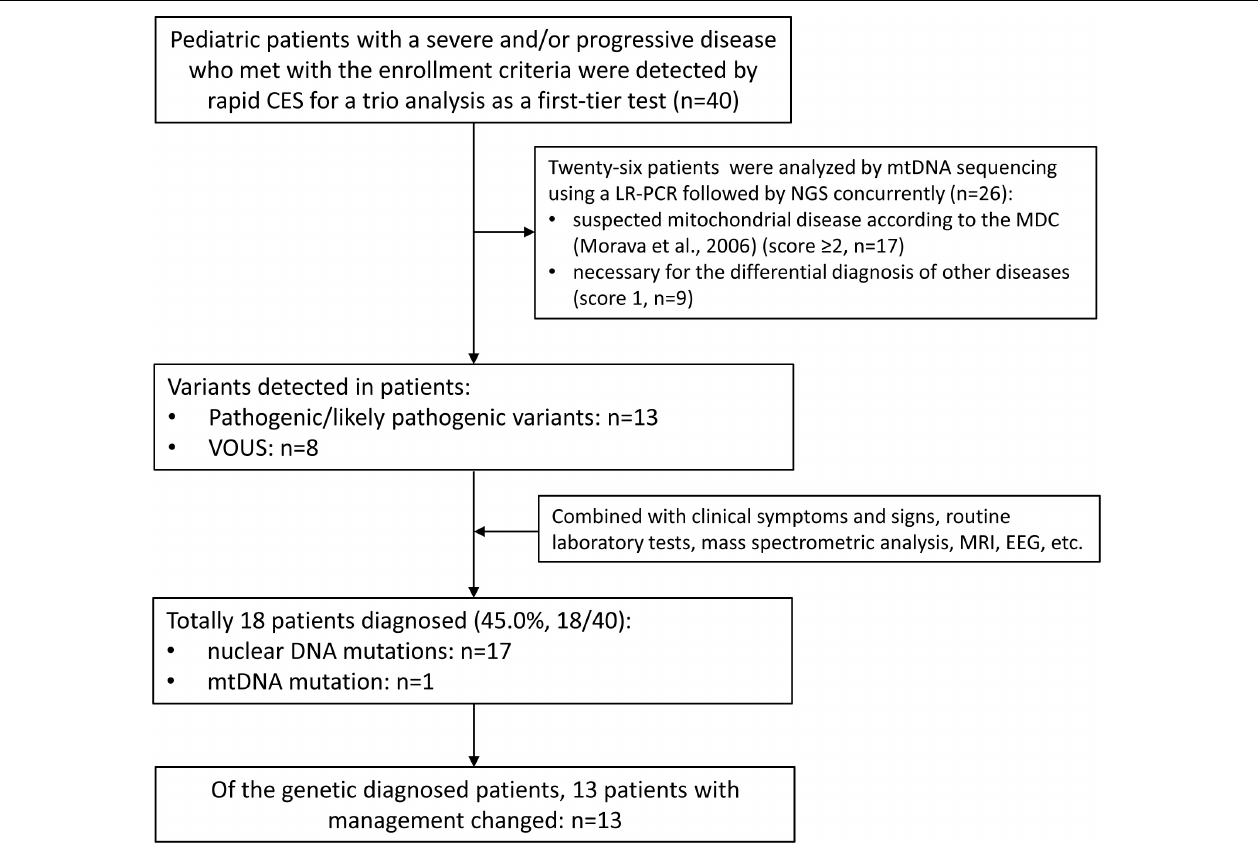
FIGURE 1 | The flowchart of the genetic diagnosis in the 40 pediatric patients. CES, clinical exome sequencing; MDC, mitochondrial disease criteria; VOUS, variants of unknown